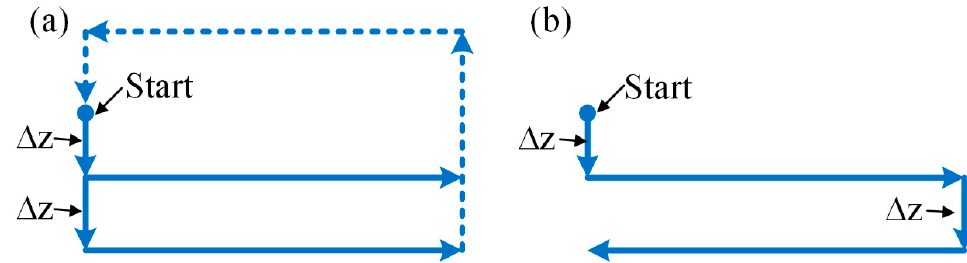
Figure 9. Schematic diagram of two types of paths in straight-line path milling: ( a ) unidirectional path and ( b ) reciprocating path. Table 1. Simulation parameters.